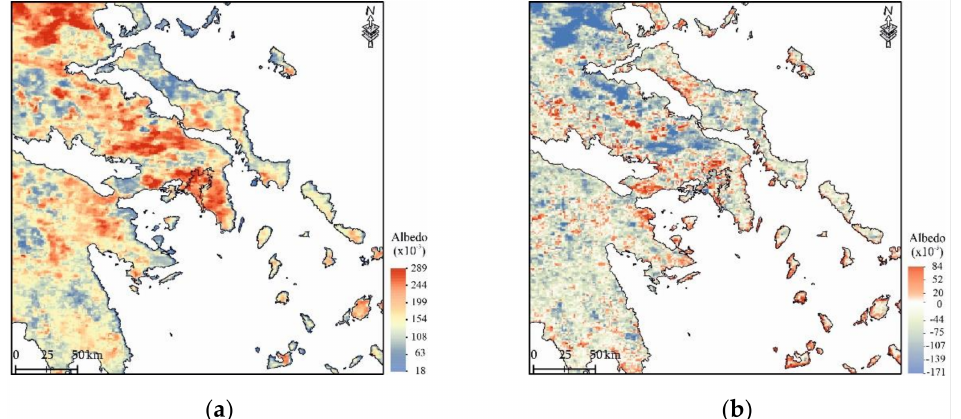
Figure 3. ( a ) Spatial distribution of average albedo from 26 June 2002 to 11 July 2002; ( b ) Spatial change of 16 days average albedo between the periods starting on 26 June 2002 and on 14 September 2002.